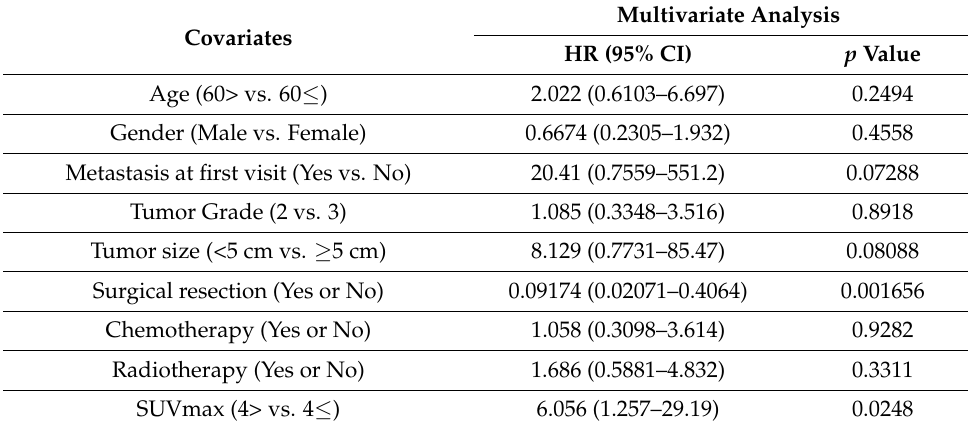
Table 7. Multivariate Cox regression model of OS in